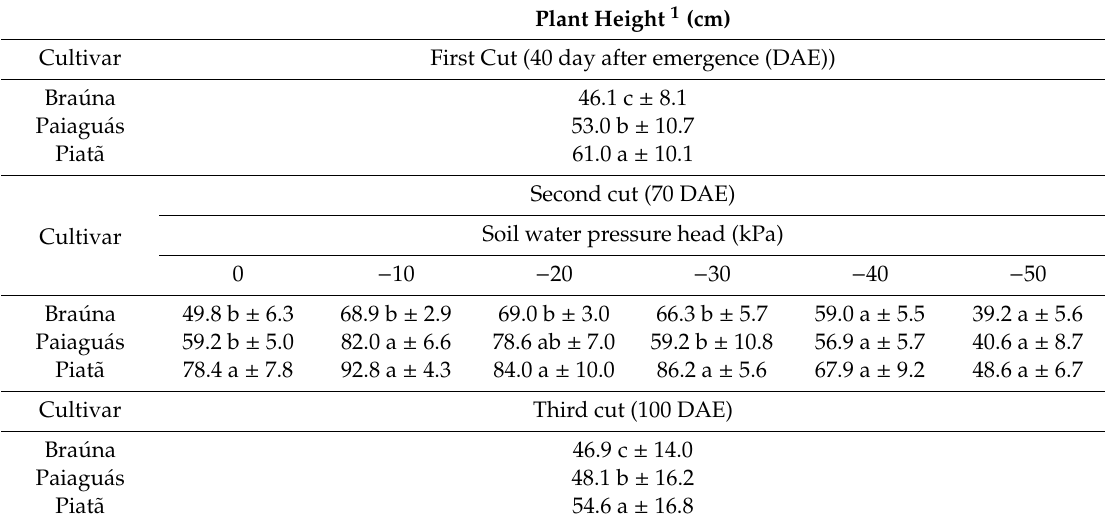
Table 2. E ff ect of soil water pressure head on plant height ( Brachiaria brizantha cultivars) for the three cutting